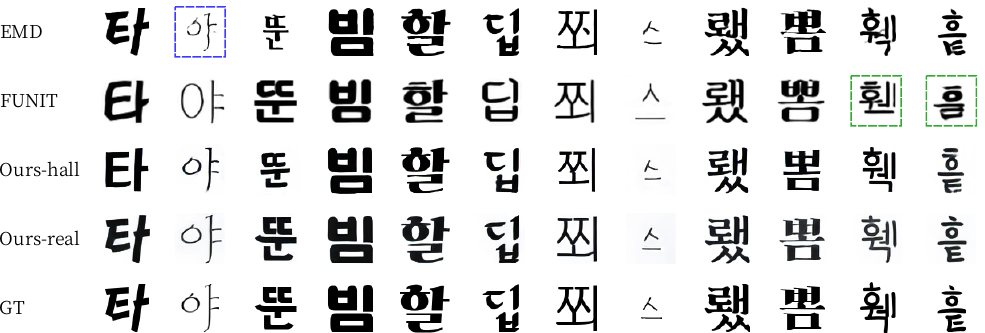
Figure 11. Examples of Korean seen font style generation. The presented characters were not shown in the training phase.